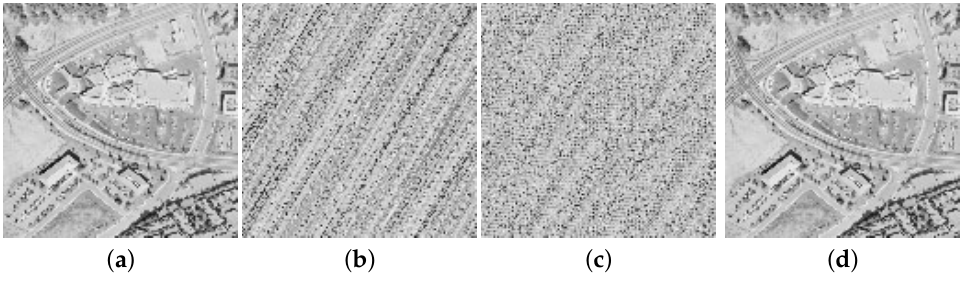
Figure 5. Periodic phenomenon of a cat map applied on a standard image. ( a ) aerial 128 × 128; ( b ) 3 iterations; ( c ) 50 iterations; ( d ) 96 iterations.